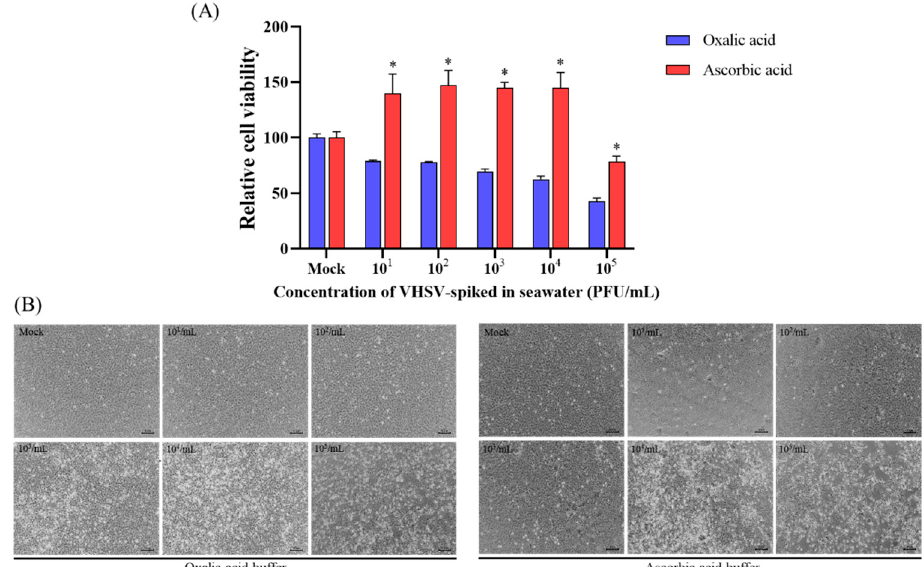
Figure 2. Comparison of cell viability and morphology in EPC cells inoculated by VHSV concentrates. VHSV-spiked seawater (1 × 10 1 to 1 × 10 5 PFU/mL) was concentrated using the oxalic or ascorbic acid buffer, and after 48 h post-infection in EPC cells, the cell viability and morphology were analyzed. Statistical analysis was performed via a two-way ANOVA (*, p < 0.05) using GraphPad Prism software version 9.5.0. ( A ) Relative cell viability (means ± standard deviation, SD). ( B ) The morphology of EPC cells 48 h post-infection.